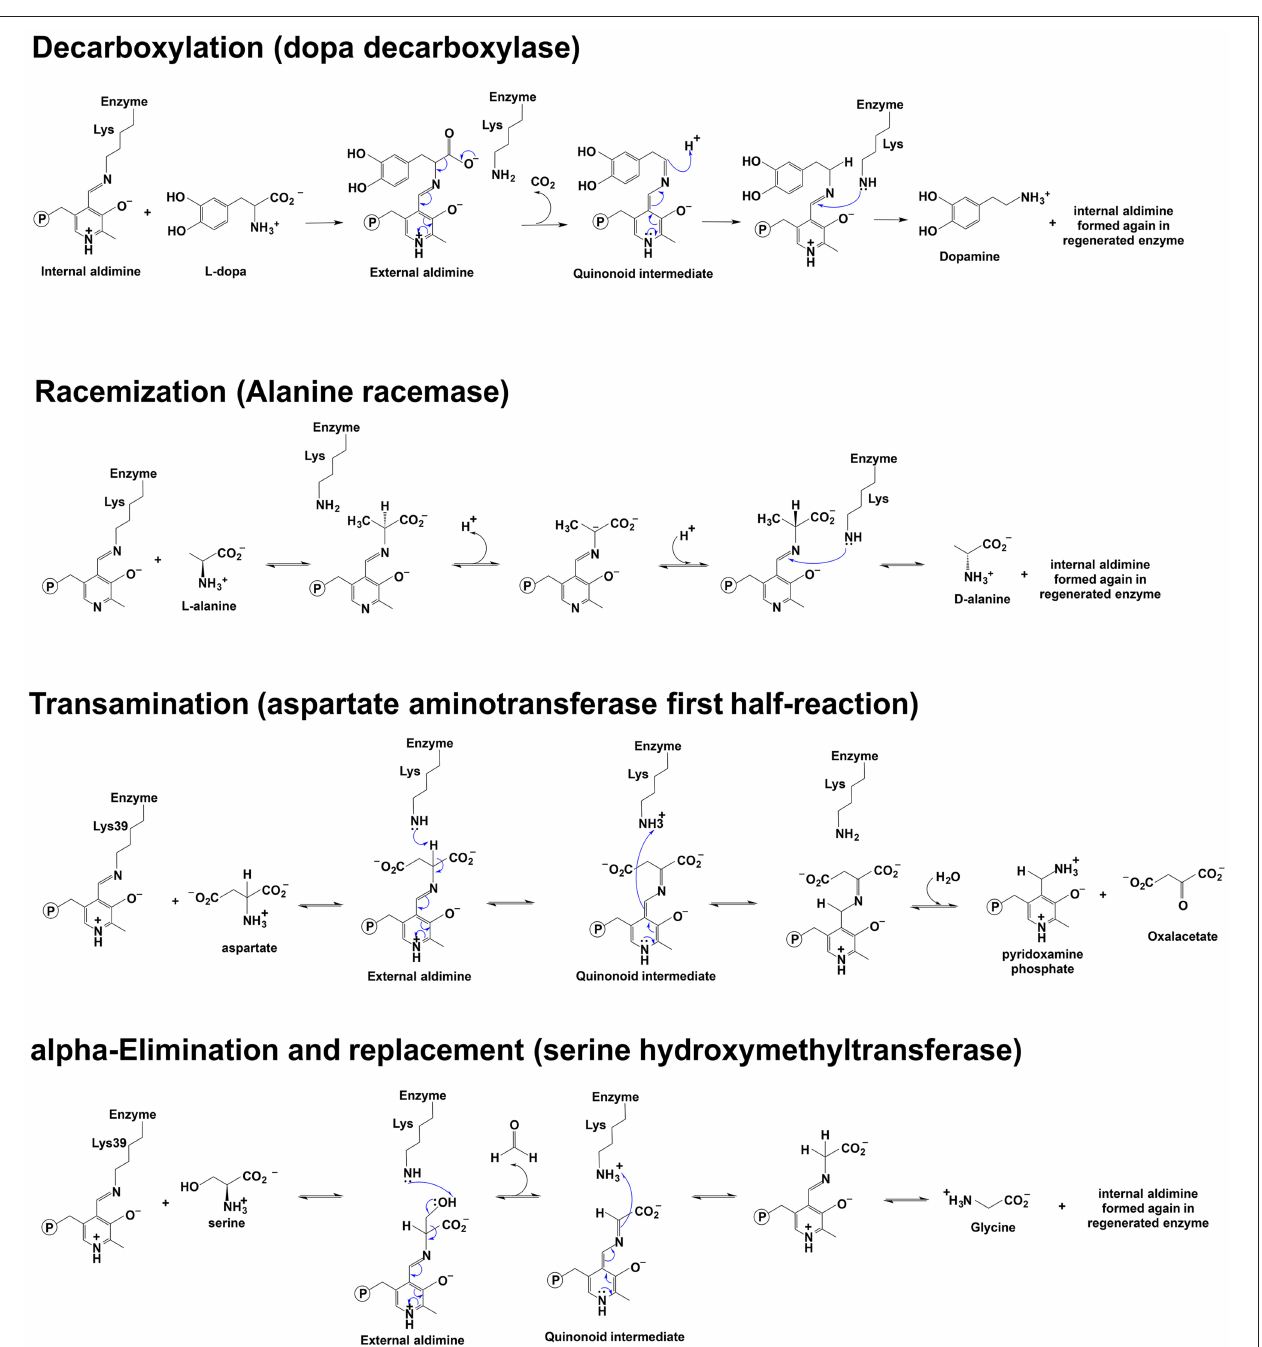
FIGURE 1 | Scheme depicting of examples of the reaction mechanisms catalyzed by PLP-dependent enzymes. Reaction mechanisms of decarboxylation, racemization, transamination, and α -elimination and replacement are shown (Watanabe et al., 1999, 2002; Eliot and Kirsch, 2004; Toney, 2014).